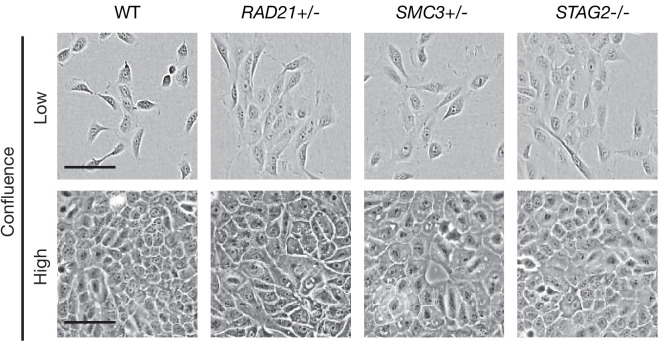
Cell morphology of MCF10A parental and cohesin-deficient cells grown at low and high confluence.MCF10A cells were grown in low (1000 cells/well) and high density (4000 cells/well) in 96-well plates. Cohesin-deficient cells display a cobblestone-like morphology that is similar to MCF10A parental cells (WT). Scale bar, 250 μM.